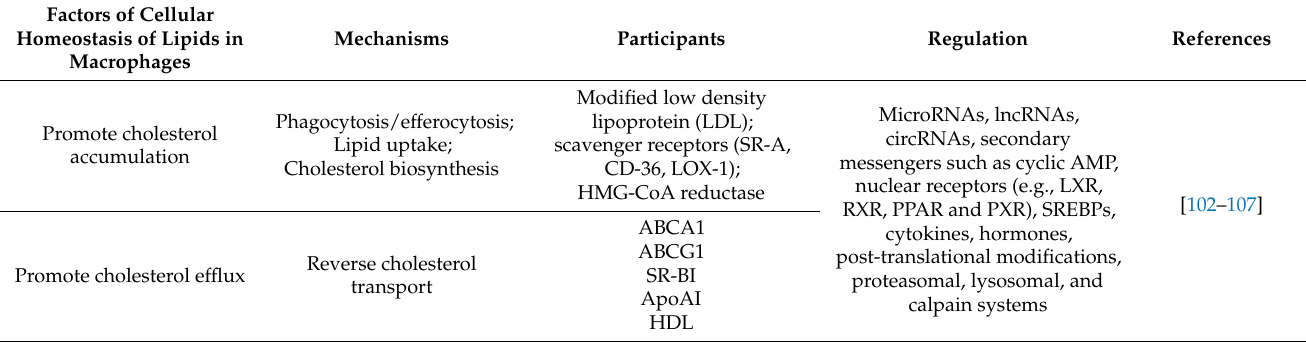
Table 1. Some pathways of regulation of cellular cholesterol homeostasis in